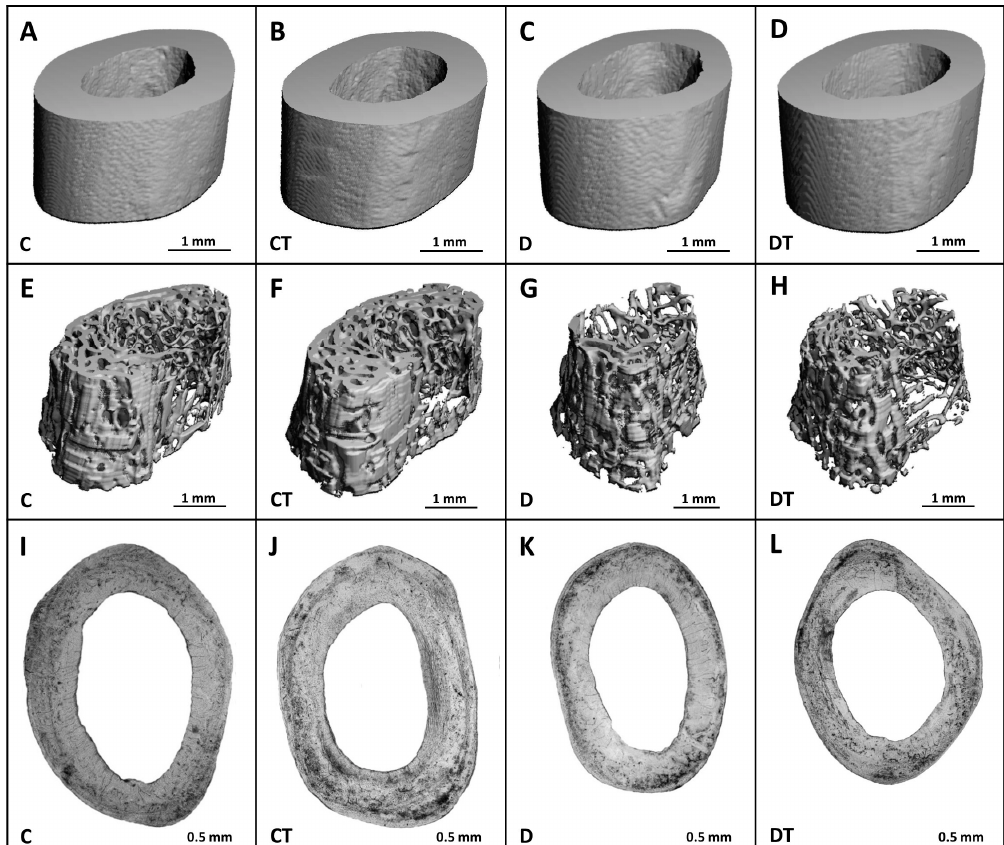
Figure 5. Micro-CT images of the cortical ( A – D ) and trabecular ( E – H ) bone and microscopic images of the cortical bone ( I – L ) in non-diabetic rats (C), those treated with cemtirestat (CT), STZ-induced diabetic rats (D), and those treated with cemtirestat (DT).